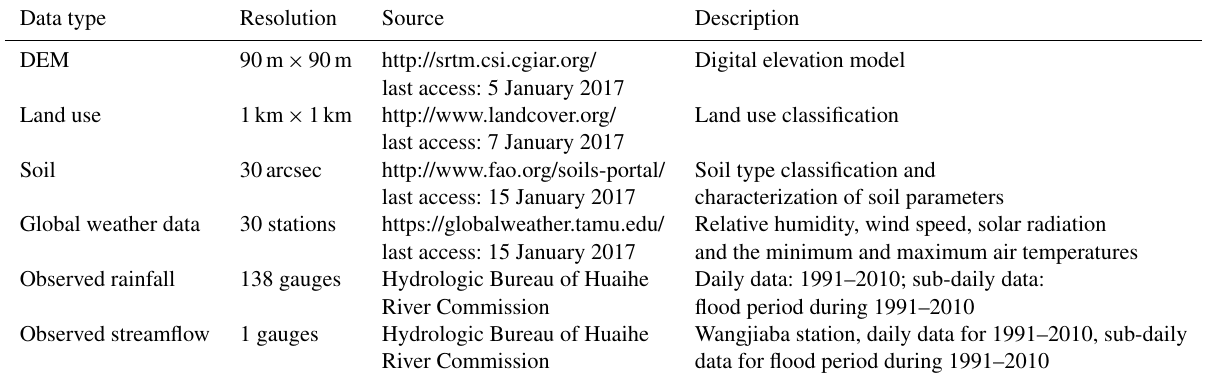
Table 1. SWAT model input data and sources for the Wangjiaba (WJB)